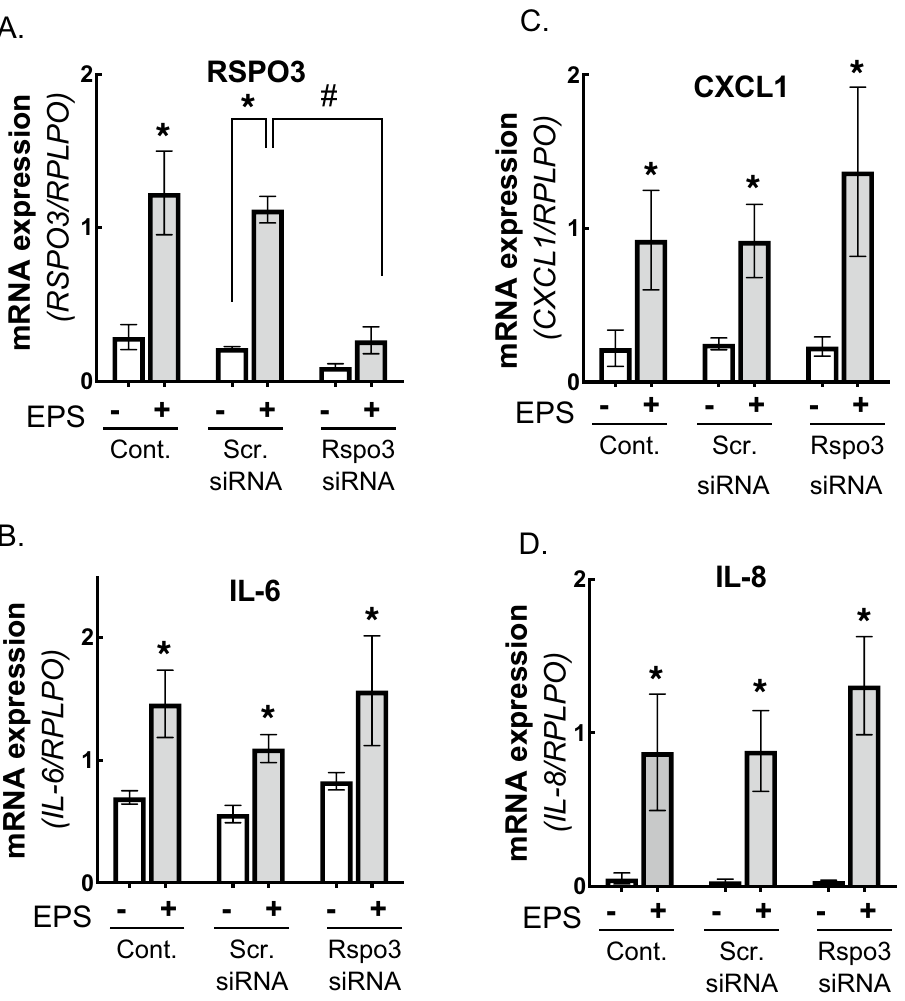
Figure 4. Effects of siRNA-mediated R-spondin 3 (RSPO3) silencing on EPS-induced expressions of other myokines in human myotubes. EPS (1 Hz, 4-ms, 20 V/25 mm) was applied to the differentiated human myotubes treated with siRNAs as described in the Methods. Total RNA samples were prepared and subjected to RT-PCR analysis to evaluate mRNA levels for RSPO3 ( A ), IL-6 ( B ), CXCL1 ( C ) and IL-8 ( D ). Data normalized using RPLP0 transcript were averaged over 3 independent experiments. Multi factor ANOVA with Tukey’s multiple comparison test was used for statistical analyses; the significance of the effect of EPS is denoted as *P < 0.05; the effect of sRNAs compared to the scramble siRNAs control is denoted as # < 0.05. Note that RSPO3 expression is effectively reduced by RSPO3 siRNAs but not by scramble control